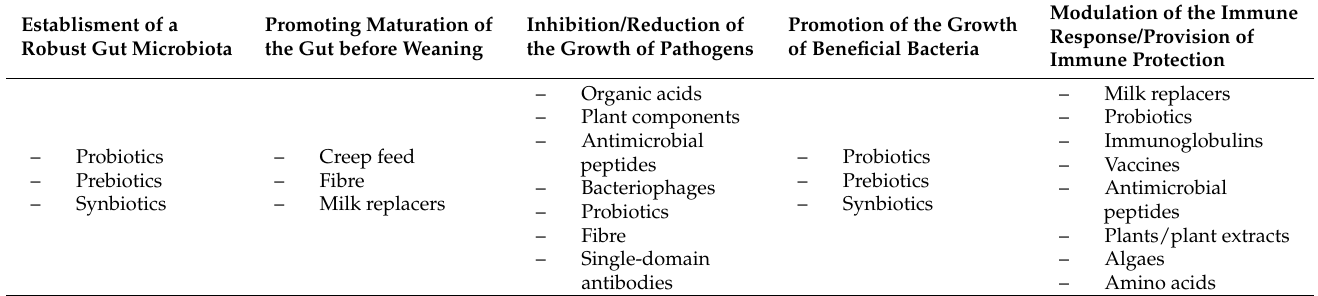
Table 1. Proposed modes of action of various strategies to prevent post-weaning diarrhoea in piglets. Establisment of a Promoting Maturation of Robust Gut Microbiota the Gut before